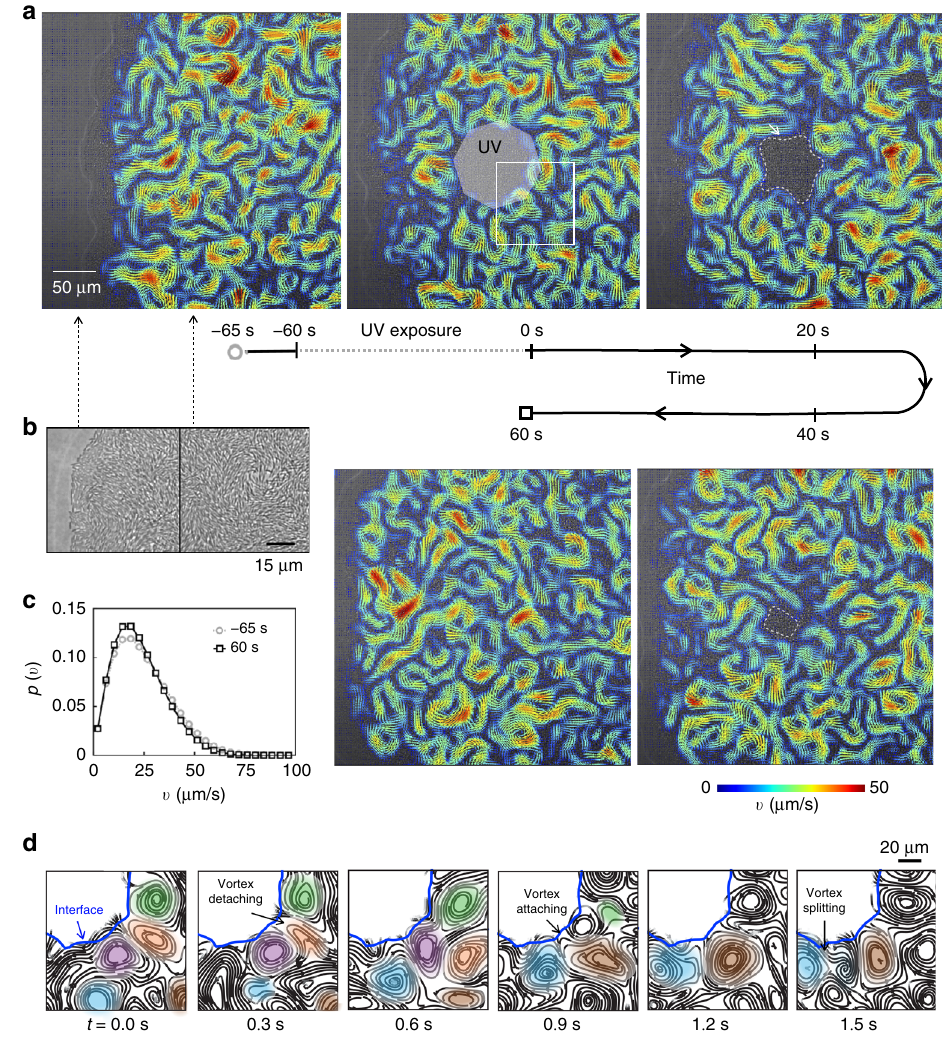
Fig. 1 Creation and dissolution of an active – passive interphase boundary in a bacterial swarm. a A series of snapshots of the expanding edge of a Serratia marcescens swarm taken over time. The colony was cultured on an agar substrate, and its expanding edge (marked by a precursor fl uid fi lm that appears as white curve) is moving from right to left. The swarm shows long-range collective fl ows, with strong velocity fi elds (PIV; overlaid color). A large domain of passive, immobile bacteria is created by exposing a region of the swarm to high intensity ultraviolet (UV) light (highlighted octagon). An interphase boundary forms between the passivated and active bacteria. When the light source is switched off ( t = 0 s), the active unexposed bacteria deform the interphase boundary and penetrate the passive region. Over time, active bacteria convect immobile bacteria away from the passive domain, causing the boundary to erode and propagate inward. The boundary is manually traced in white for visualization. The swarm dissolves the passive phase in 60 s, with interface speeds greater than that of expanding colony edge. b The swarm edge (close-up) features densely packed cells with local polarity and nematic order. c The swarm ’ s collective motion recovers after dissolution as shown by the probability distribution of bacterial speeds p ( v ), before and after exposure (data shown for representative experiment, collected from 5 s interval of PIV data). d A montage of the fl ow streamlines — from the highlighted box in a — reveals the motion of vortices (labeled by color) at the interface (blue line). Vortices starting in the bulk can collide and attach to the interface (labeled brown vortex for example); some vortices at the surface detach and move away (green, orange). Others fade away (purple) or split (dark blue splits from light blue vortex in right tile). Data shown here is from a single experiment; results were repeated for a minimum of N = 4